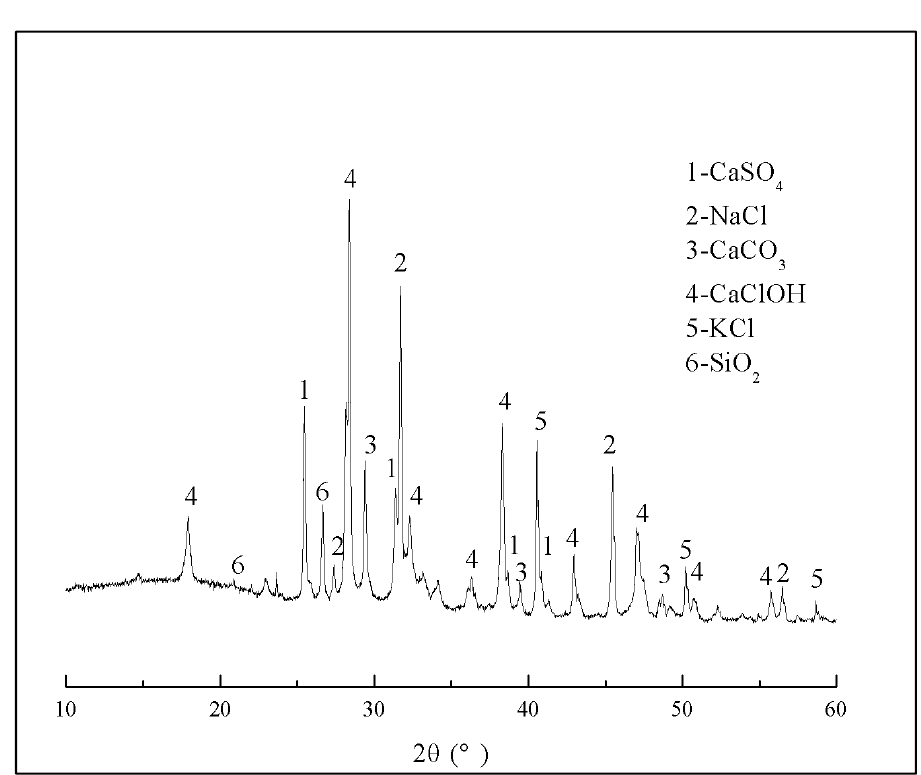
Figure 2. The XRD pattern of fly ash.